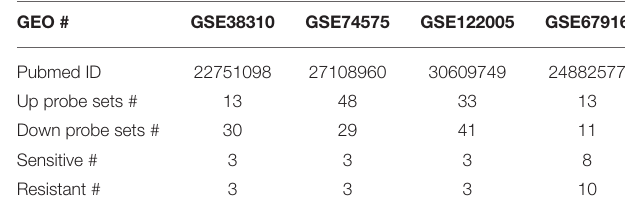
TABLE 2 | Summary of four datasets (sensitive vs. resistant cells) used for CMap